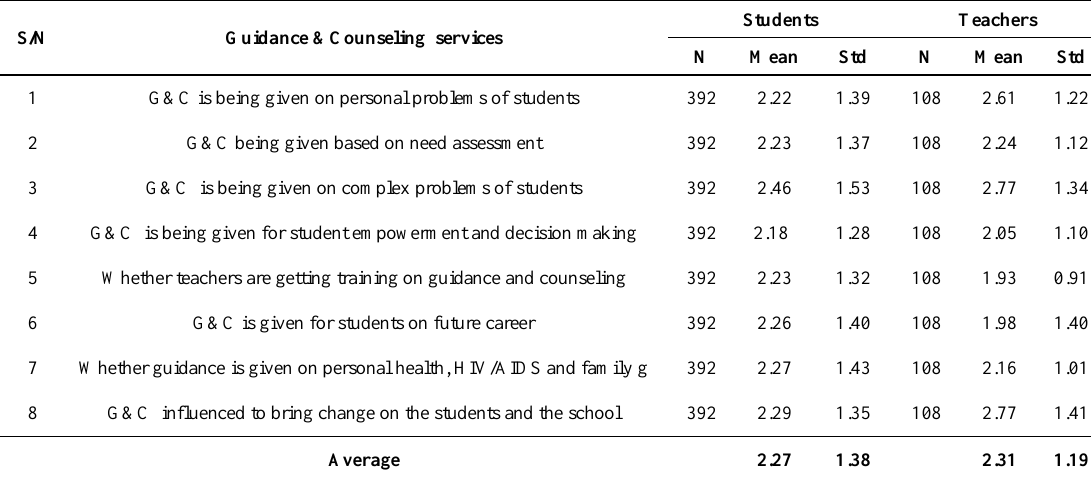
Table 4. Practices of guidance and counseling